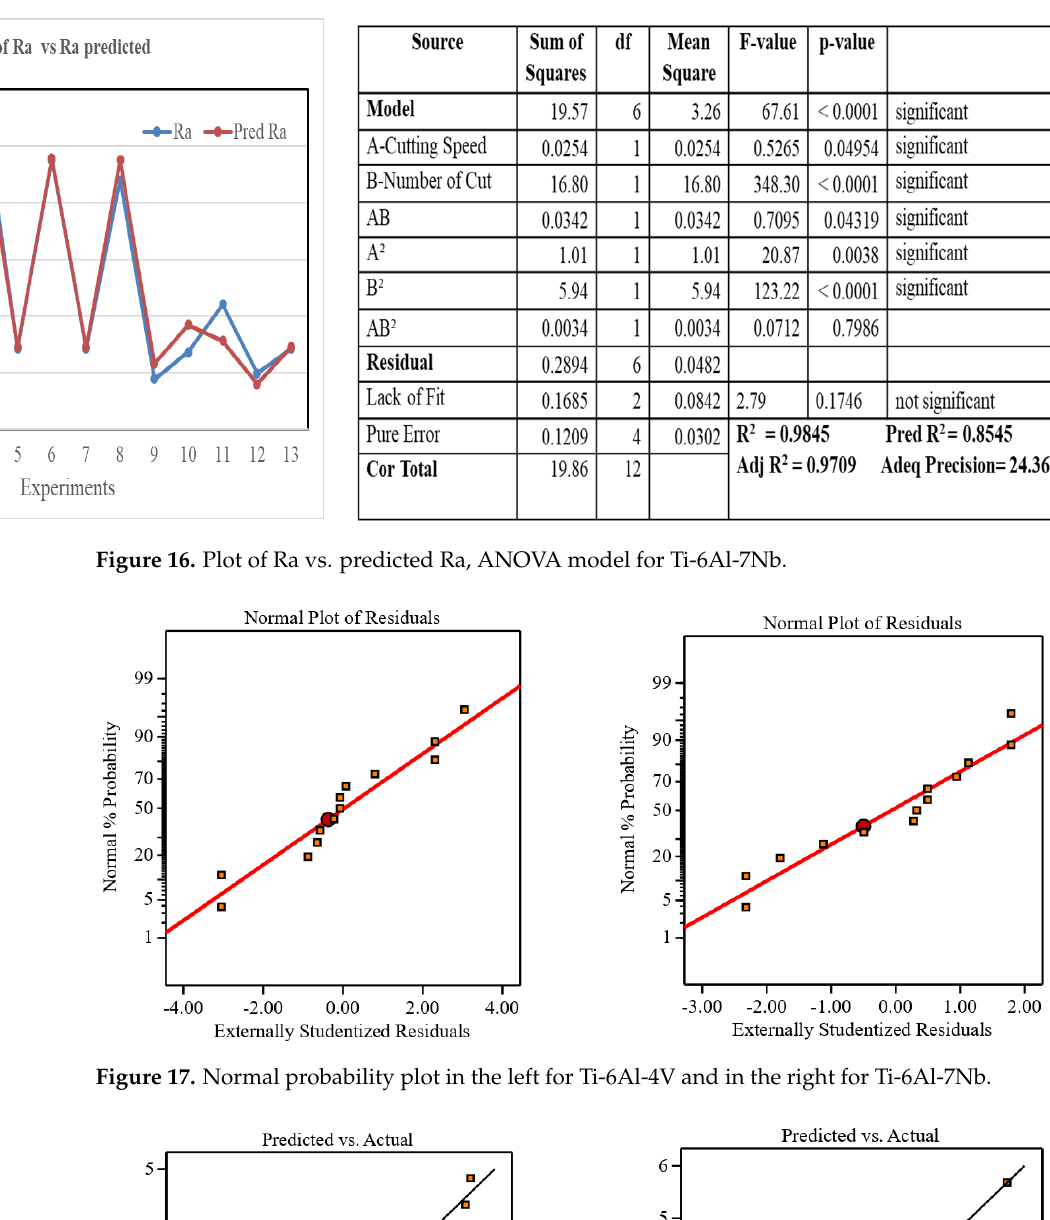
Figure 15. Plot of Ra vs predicted Ra, ANOVA model for Ti-6Al-4V.